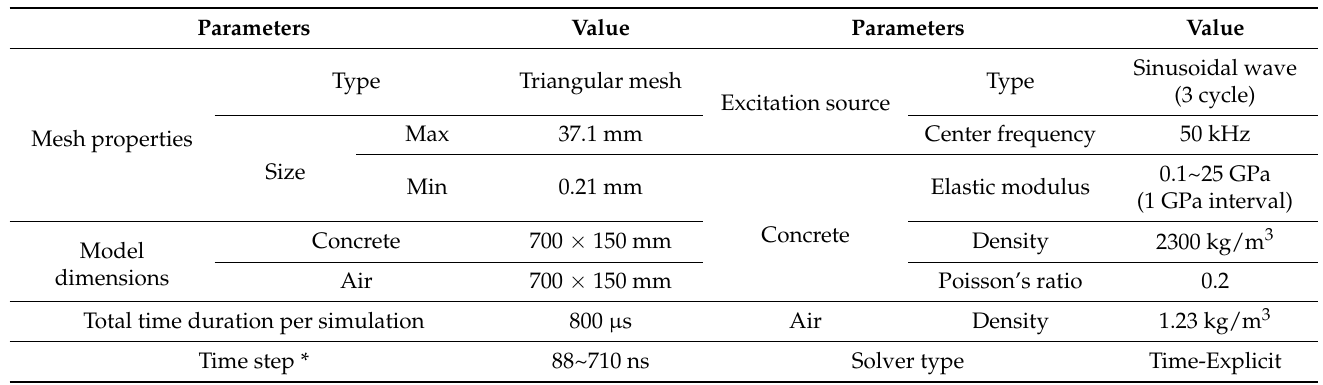
Table 1. Summary of the parameters used for numerical